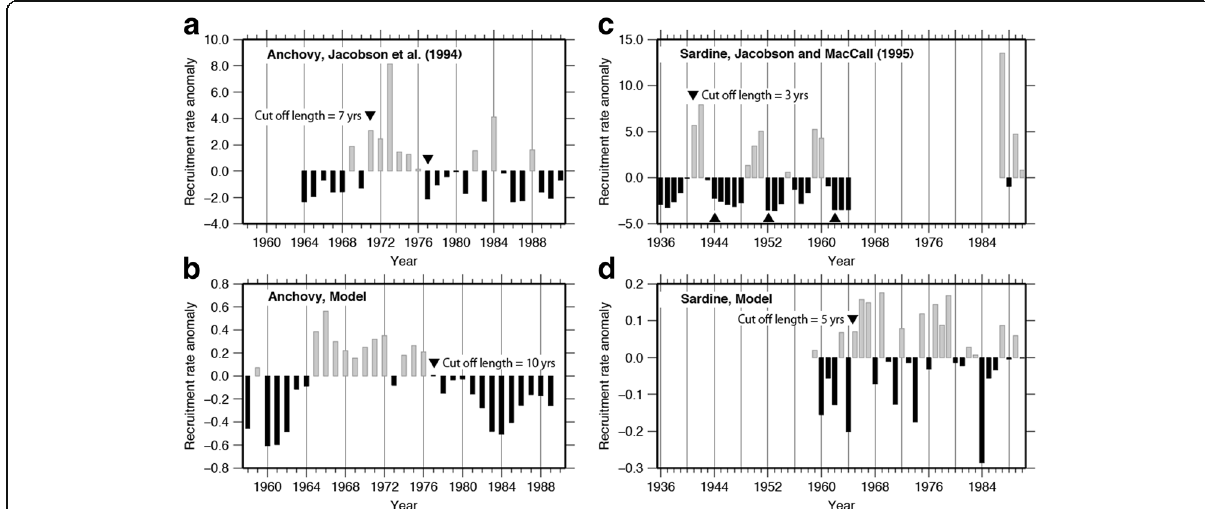
Fig. 2 Comparison of recruitment rate anomaly between model simulation and estimates based on analysis of field data. Time series of anchovy a estimated by Jacobson et al. (1994) from 1964 to 1991, b estimated by the climate-to-fishery model from 1958 to 1990, normalized sardine rate c estimated by Jacobson and MacCall (1995) from 1936 to 1964 and from 1987 to 1991 and d estimated by the climate-to-fishery model from 1958 to 1990. Mean recruitment rate that was used for calculating anomaly is a 2.71, b 1.40, c 4.09, and d 0.75. Triangles represent years when the regime shift index detected by RSI. Cutoff lengths are a 7 years, b 10 years, c 3 years, and d 5